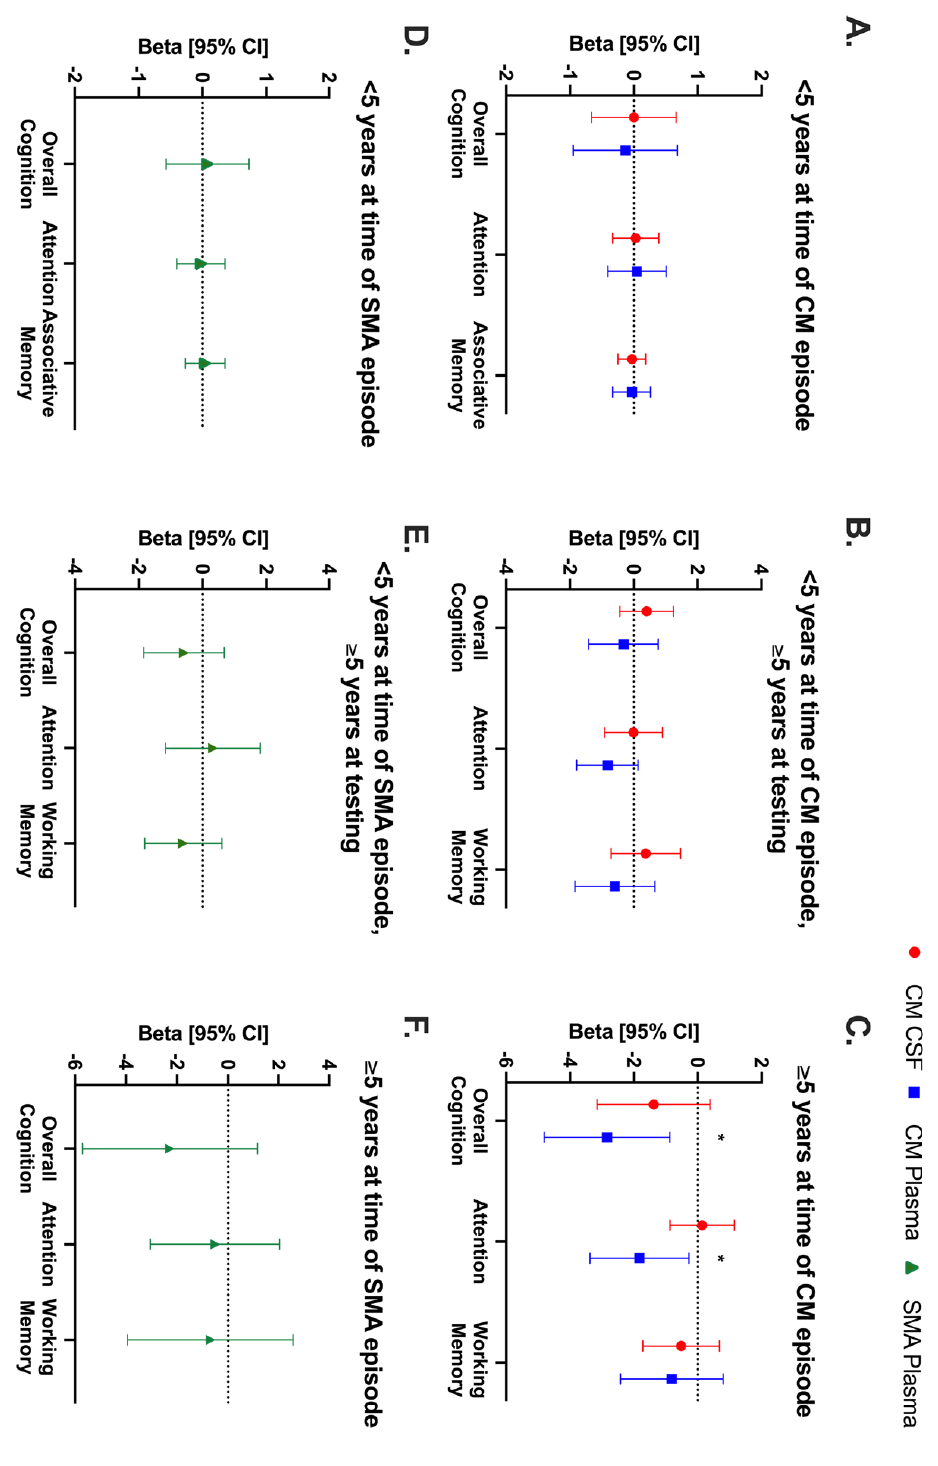
Figure 3. Association of risk factor-adjusted log(10)-transformed plasma and CSF sST2 levels with cognitive outcome z-scores in children with cerebral malaria (CM) or severe malarial anemia